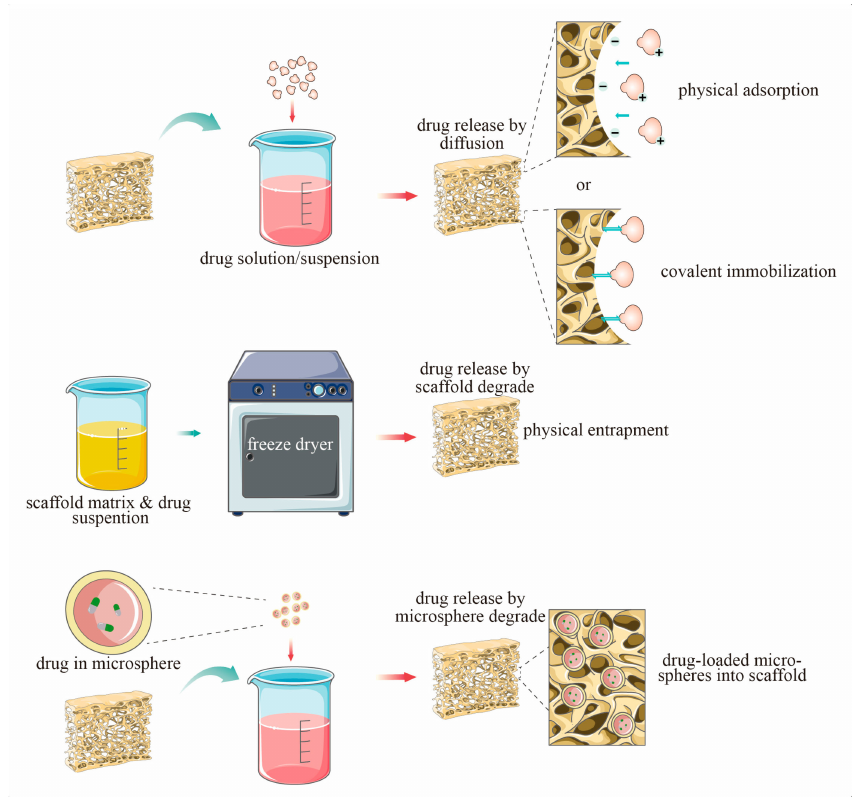
Figure 3. Loading methods of drugs on n-HAp